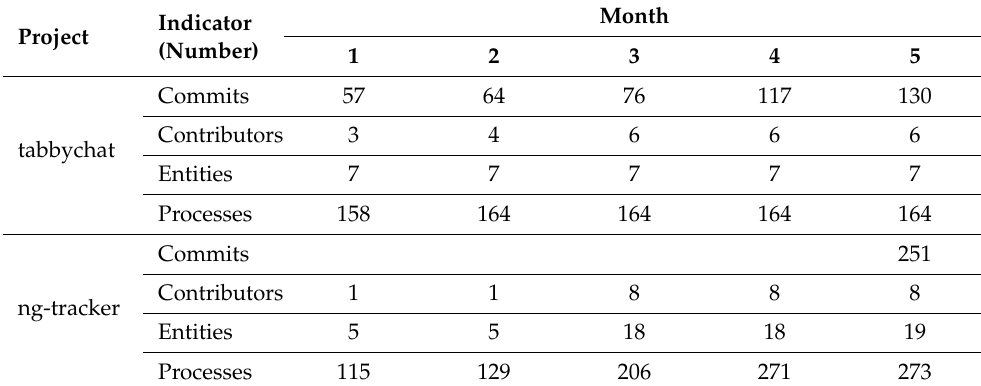
Table 1. Time series extracted from analyzed repositories.